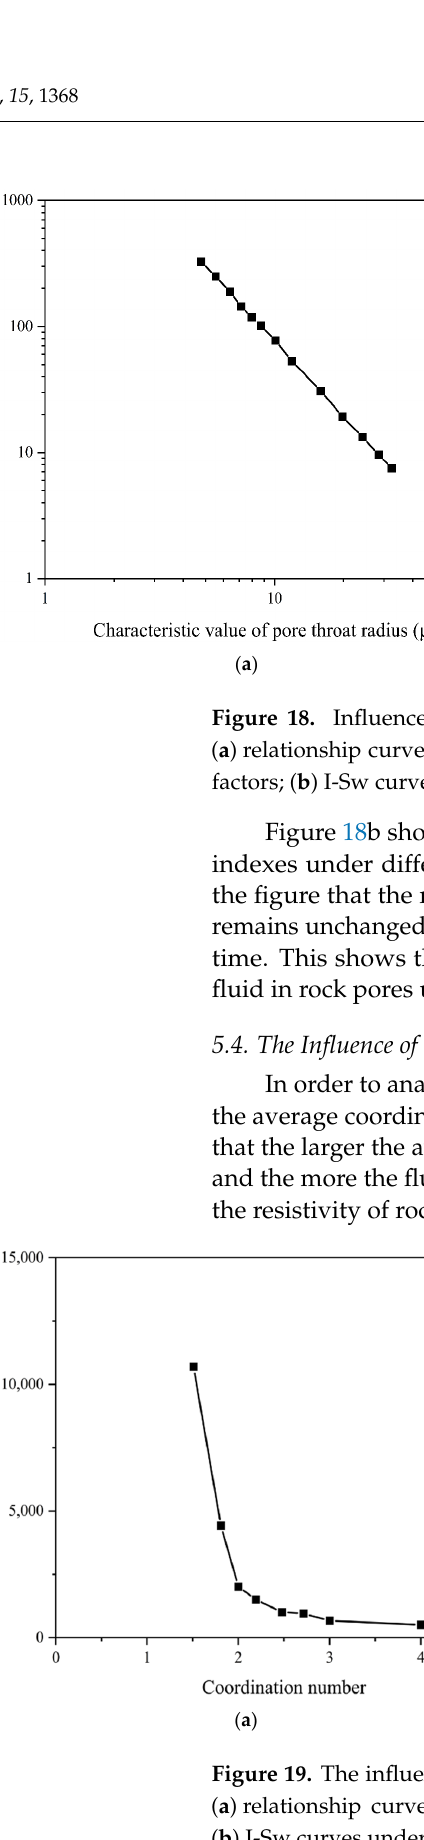
( b ) I-Sw curves under different average coordination